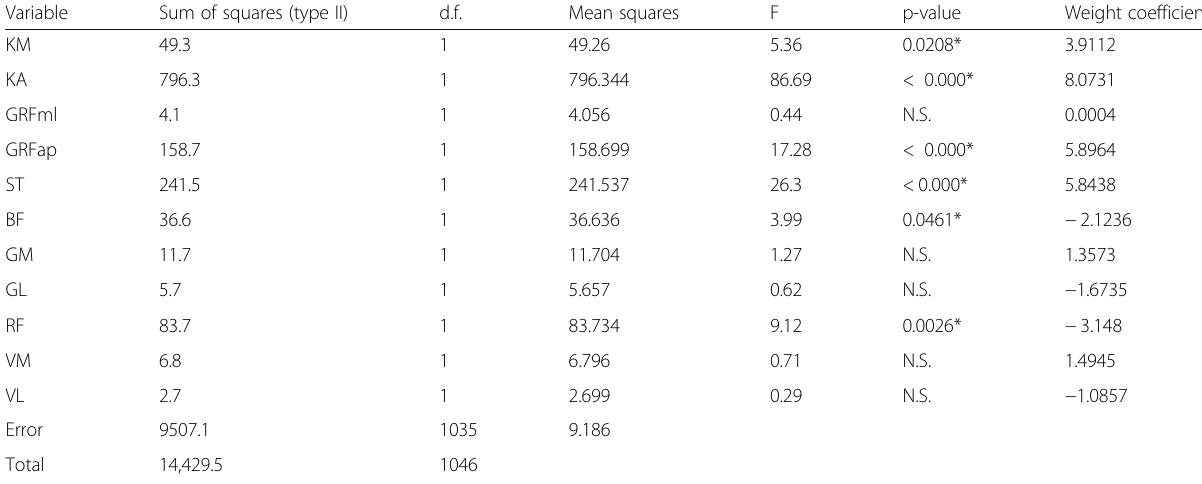
Table 3 Sum of squares, degrees of freedom, mean squares, F-values, p -values and coefficient of the N-way ANOVA with the dependent variable being dynamic anterior tibia translation Variable Sum of squares (type II) d.f.